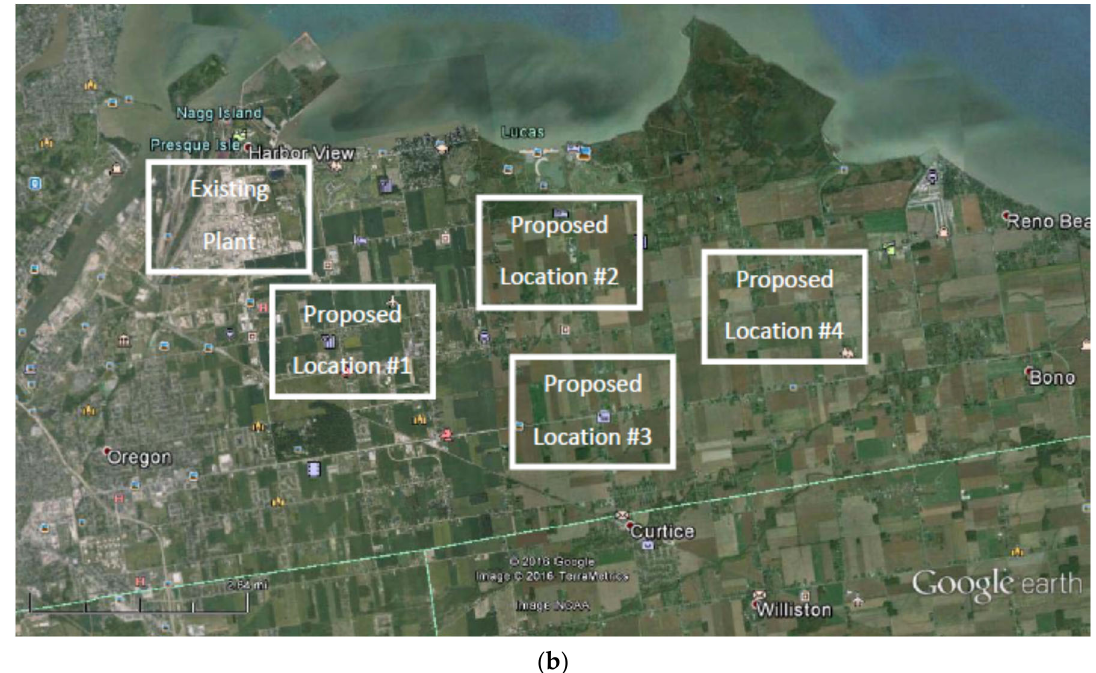
Figure 3. ( a ) Water body and watershed polygons. ( b ) The layout of existing and proposed plant locations.